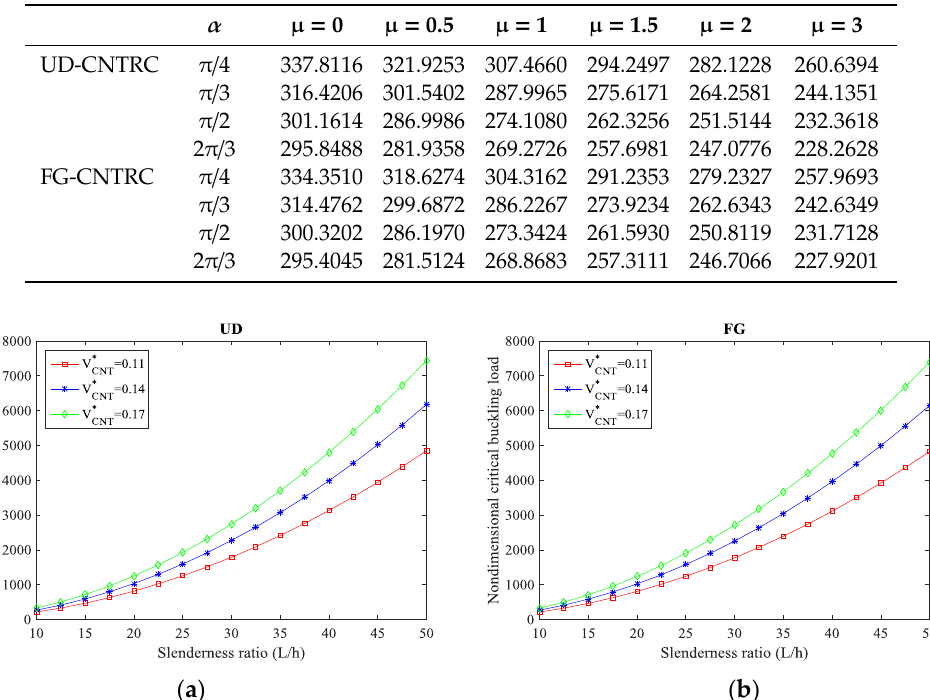
Molecules 2018 , 23 , x FOR PEER REVIEW Figure 3. Critical buckling load versus slenderness ratio for di ff erent volume fractions and distribution Figure 3. Critical buckling load versus slenderness ratio for different volume fractions and patterns of CNTs: ( a ) UD pattern, ( b ) FG pattern. ( µ = 2 nm 2 , L = 20, α = π / 3). distribution patterns of CNTs: ( a ) UD pattern, ( b ) FG pattern. (µ = 2 nm 2 , L = 20, α = π/3).